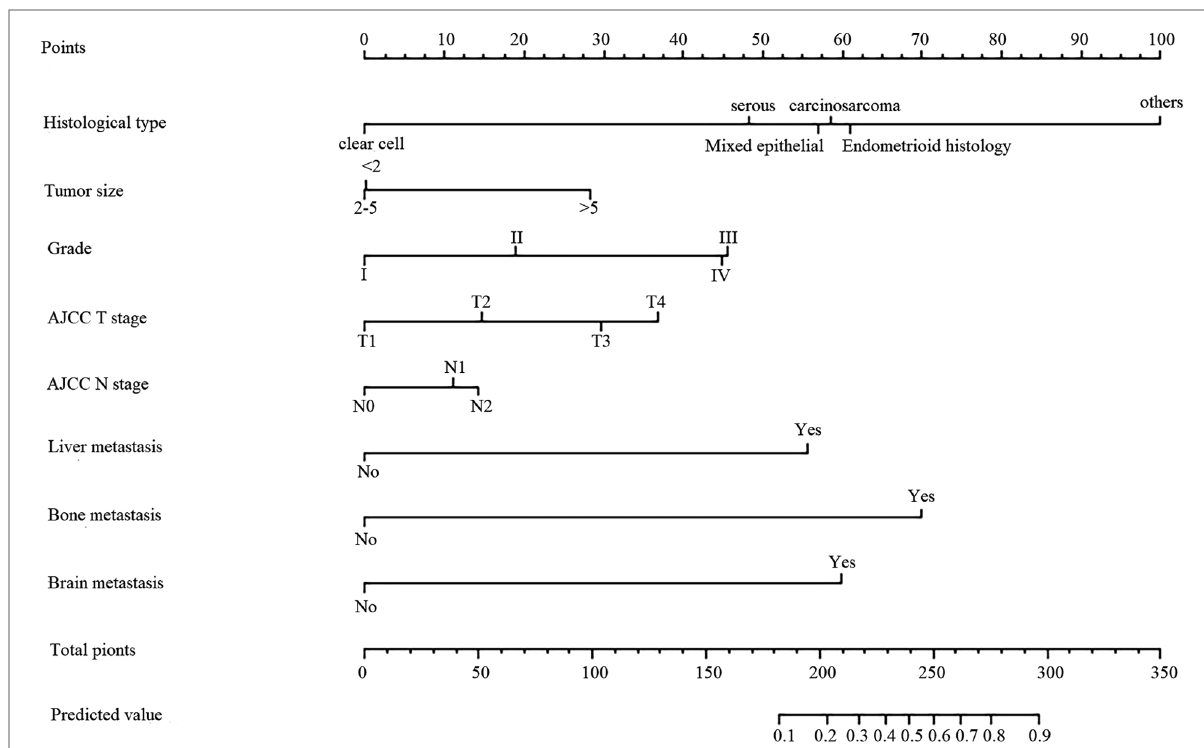
FIGURE 2 Nomogram predicting the probability of LM. The fi rst line shows the point assignment of each variable. Lines 2 – 9 show the variables included in the model. When using a nomogram for a single patient, a point is assigned to each variable based on clinicopathological characteristics, and all points are added. Each score in the total score in row 9 will correspond to the probability of risk in the last